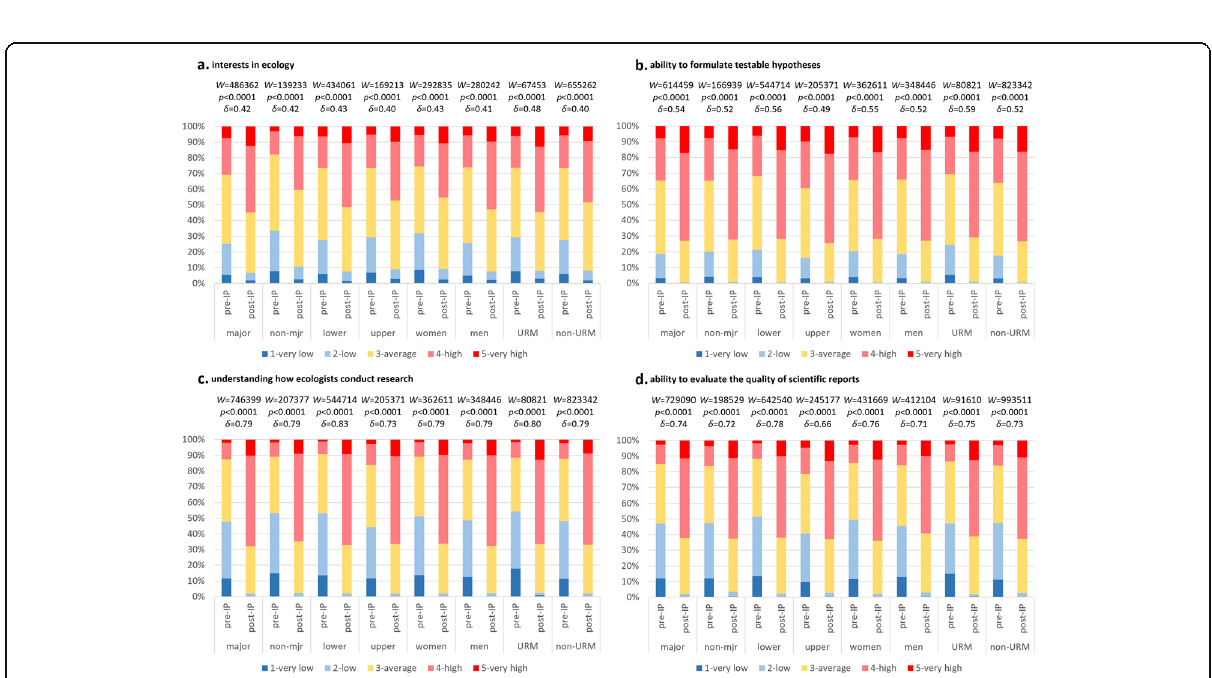
Fig. 3 Self-perception of learning by student groups. Distributions of self-reported levels of a interest in ecology, b ability to formulate testable hypotheses, c understanding how ecologists conduct research, and d ability to evaluate quality of scientific report, before (pre-IP) and after (post- IP) the inquiry project, for majors and nonmajors ( n = 1777 and 937), lower- and upper-division students ( n = 1052 and 1062), women and men ( n = 1361 and 1353), and under-represented minorities (URM) and other ethnicities ( n = 630 and 2084). The W statistic and p value for Wilcoxon signed-rank test and the effect size (Cliff ’ s delta, δ ) are shown above each